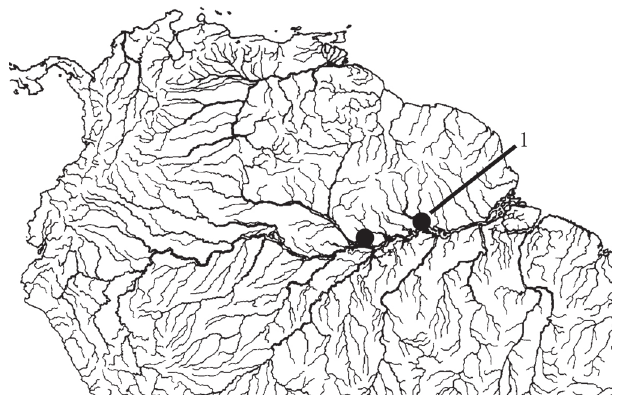
Fig. 4. Distribution of Tetranematichthys barthemi . 1 = type locality. Point 1 represents more than one